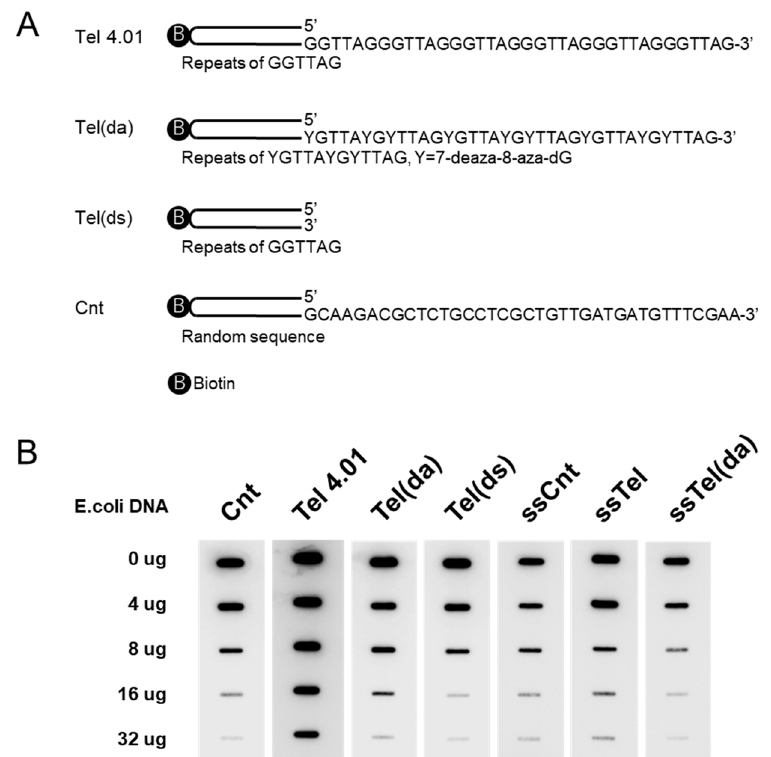
Figure 3. ( A ) Schematic illustration showing double-strand oligonucleotides. Full base sequences of each oligonucleotide are shown in Materials and Methods section. ( B ) Flag-hnRNP U FL fusion proteins extracted from COS1 cells were IP:d with anti-Flag agarose gel. IP were mixed with indicated oligonucleotides, adding various weights of E. coli DNA in KCl buffer. Same treatment as in Figure 1A.